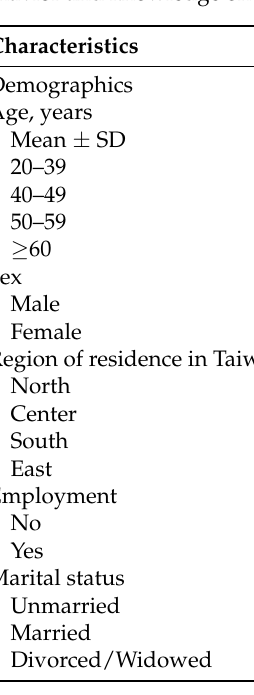
Table 1. General characteristics of study participants in a nationwide survey for COVID-19-preventive behavior and knowledge on usage of masks in Taiwan ( N =